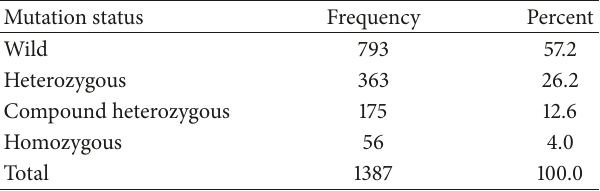
Table 1: Frequency of MEFV gene mutations in the studied